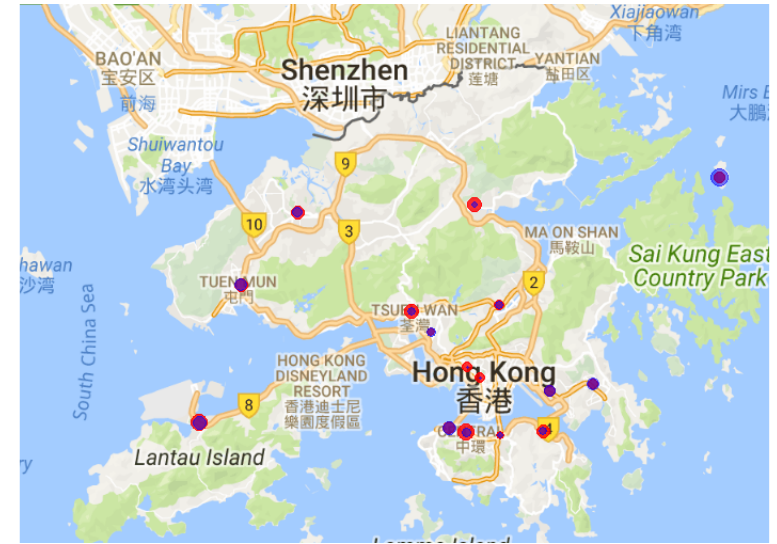
Figure 3. Spatial variations of the air quality measurements at the 16 official monitoring stations in Hong Kong in 2017: the blue circles denote NO 2 and the red circles denote PM 2.5 . The size of a circle represents the magnitude of the variance of the corresponding random